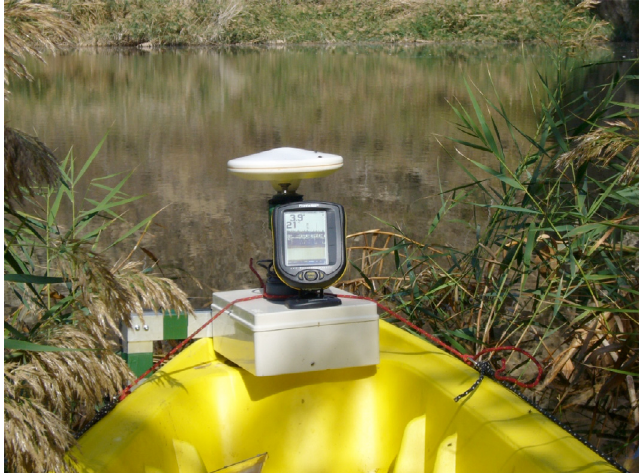
Figure 3. Particular of the bow of the kayak used for the surveys with GPS antenna and echosounder; the sonic transducer is mounted at the sub- merged end of the metal bracket on the left of the